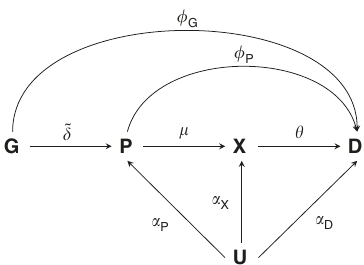
Fig. 1 Directed acyclic graphs of potential Mendelian randomisation pathways. Nodes are presented in bold face, with G representing a genetic variant, P a protein drug target, X a biomarker, D the outcome, and U (potentially unmeasured) common causes of both P , X , D . Labelled paths represent the (causal) effects between